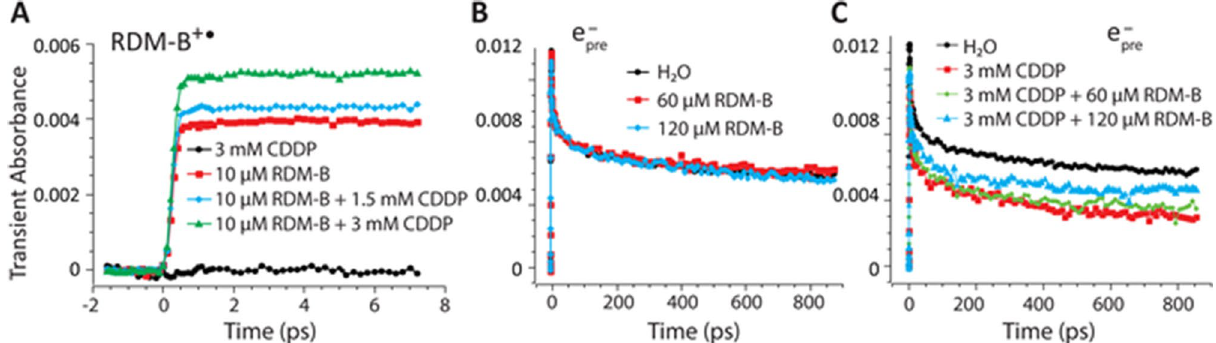
Figure 6. Femtosecond time-resolved (pump-probe) laser spectroscopic observations of the dissociative electron transfer (DET) reaction between cisplatin (CDDP) and Rhodamine-B (BV10) in aqueous solutions. ( A ) Transient absorption measurements of BV10 cation radical (RDM-B +• ) in 10 μM BV10 only, 3 mM CDDP only, and the mixtures of 10 μM BV10 and 1.5 mM or 3 mM CDDP. ( B , C ) Transient absorption measurements of prehydrated electrons (e pre− ) in pure water, 60 μM and 120 μM BV10 only solutions, and in pure water, 3 mM CDDP only and the mixtures of 3 mM CDDP with 60 μM or 120 μM 22) in Fig. 5D, BV10 alone had almost no effect on the tumor growth; when BV10 was combined with CDDP, a drastically different result was observed: the tumor growth inhibition was significantly enhanced.